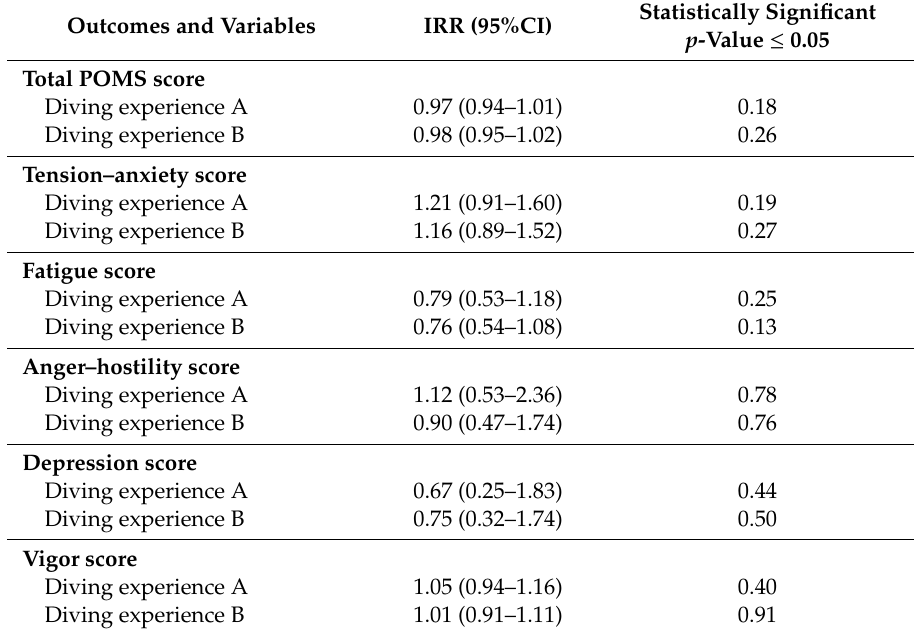
Table 4. Poisson regression model for total POMS and the di ff erent POMS categories (tension–anxiety, fatigue, anger, depression, and vigor) scores after activities, Incidence Rate Ratios (IRR) and p -values ( p ) a . Beach as activity of reference b